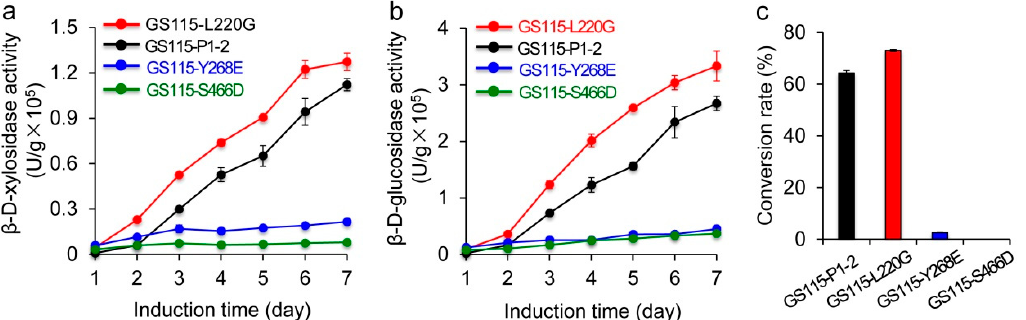
Figure 2. Comparison of β - D -xylosidase activities ( a ) and β - D -glucosidase activities ( b ), as well as conversion rates towards XDT ( c ) among the recombinant yeasts GS115-L220G, GS115-Y268E, and GS115-S466D. The recombinant yeast GS115-P1-2 is used as the control. Data are the mean ± SD. n = 3.